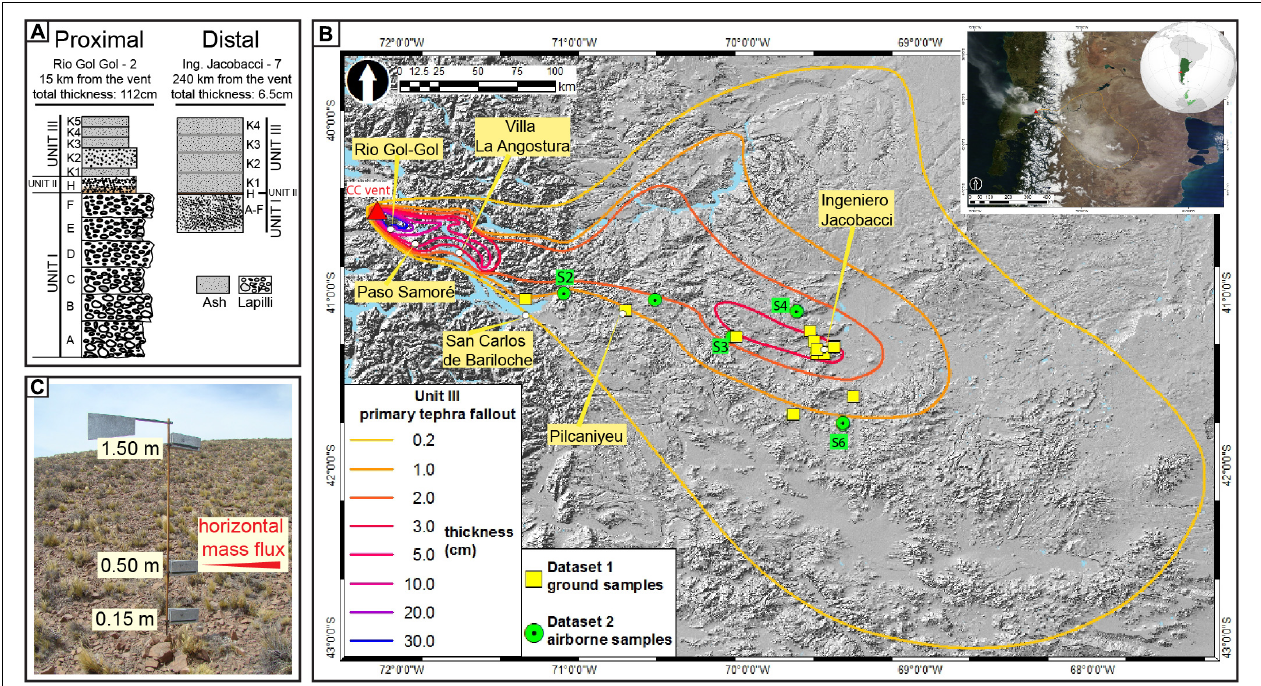
FIGURE 2 | (A) Stratigraphy associated with the 2011-Cordón Caulle primary tephra-fallout deposit showing a typical section in the proximal areas (i.e., Rio Gol-Gol, 15 km from the vent) and in the distal areas (i.e., Ingeniero Jacobacci, 240 km from the vent) (Pistolesi et al., 2015). (B) Isopach map of Unit III in cm. Sampling location of ground (i.e., Dataset 1) and airborne (i.e., Dataset 2) samples is shown. Selected sites for airborne material (i.e., Dataset 2) correspond to sites S2, S3, S4 and S6. Satellite image (MODIS-Aqua), January 2013 (top right corner) (Source: https://earthobservatory.nasa.gov/). (C) Dust-sampler vertical pole with a wind-oriented weather vane designed to collect at least 86% of the remobilised material crossing a horizontal flow through an opening of 10 cm 2 (more details in Panebianco et al.,